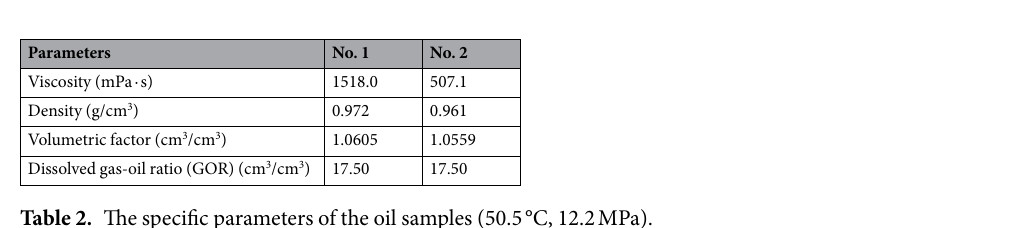
Table 2. The specific parameters of the oil samples (50.5 °C, 12.2